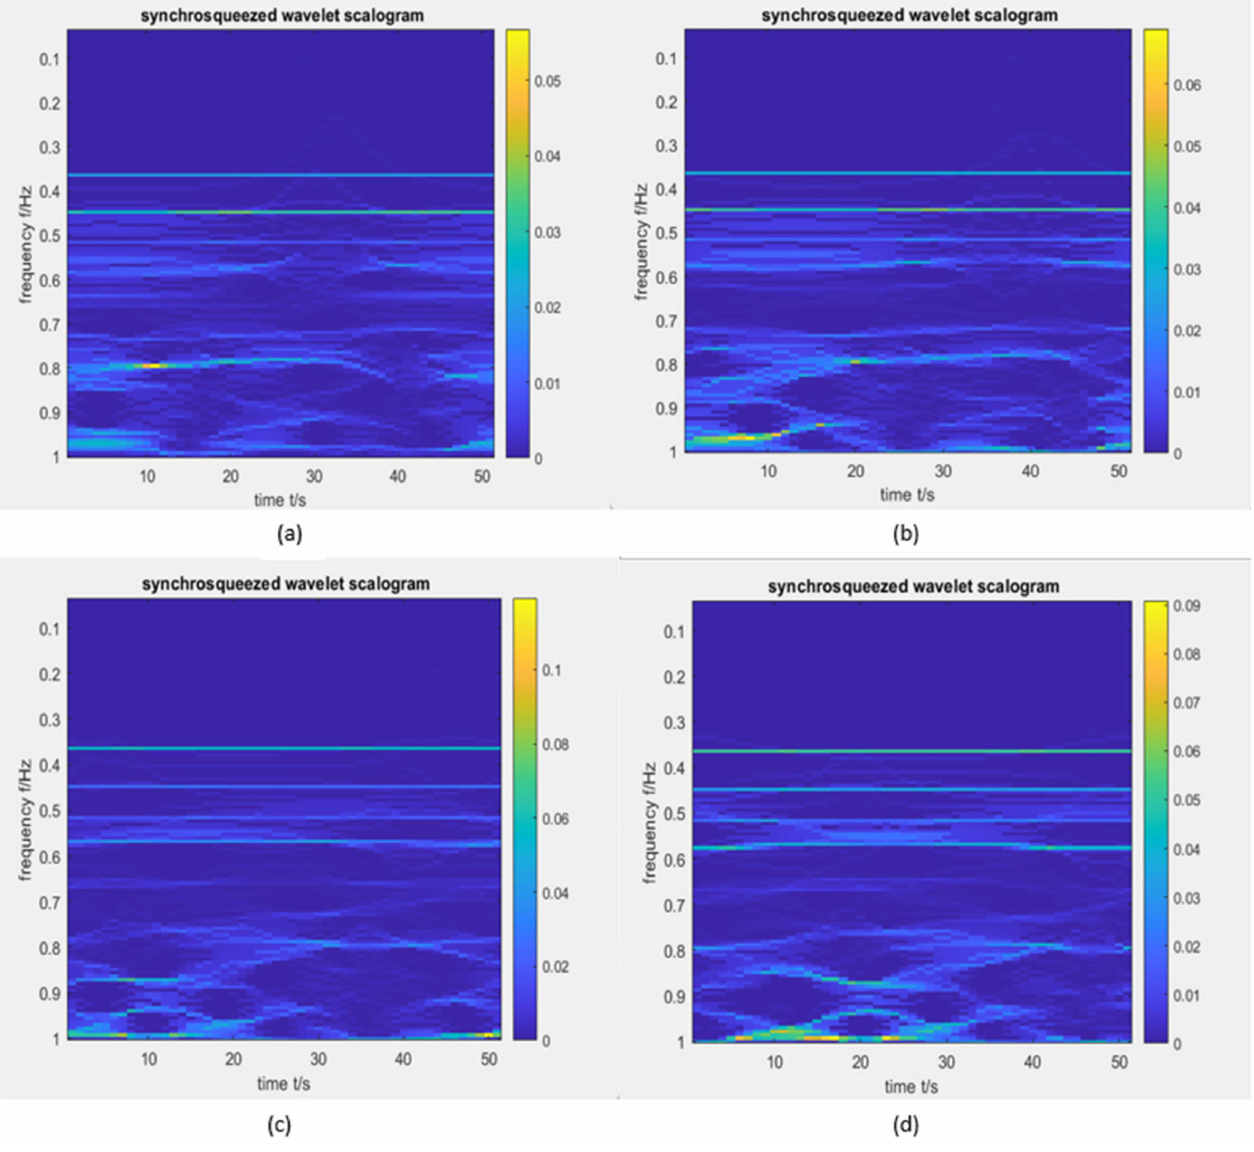
Figure 7. The synchrosqueezed wavelet transform synchrosqueezed scalograms of the four CWT scalograms shown in Figure 6: ( a ) more concentrated pulse in frequency range 0.4–0.5 Hz, and a new pulse was found around frequency 0.8 Hz, ( b ) more concentrated pulses in various frequency ranges, ( c ) more concentrated pulse in frequency range 0.9–1.0 Hz, ( d ) more concentrated pulses in frequency ranges 0.8–0.9 Hz and 0.9–1.0 Hz, moreover, the time information is explicit compared with Figure